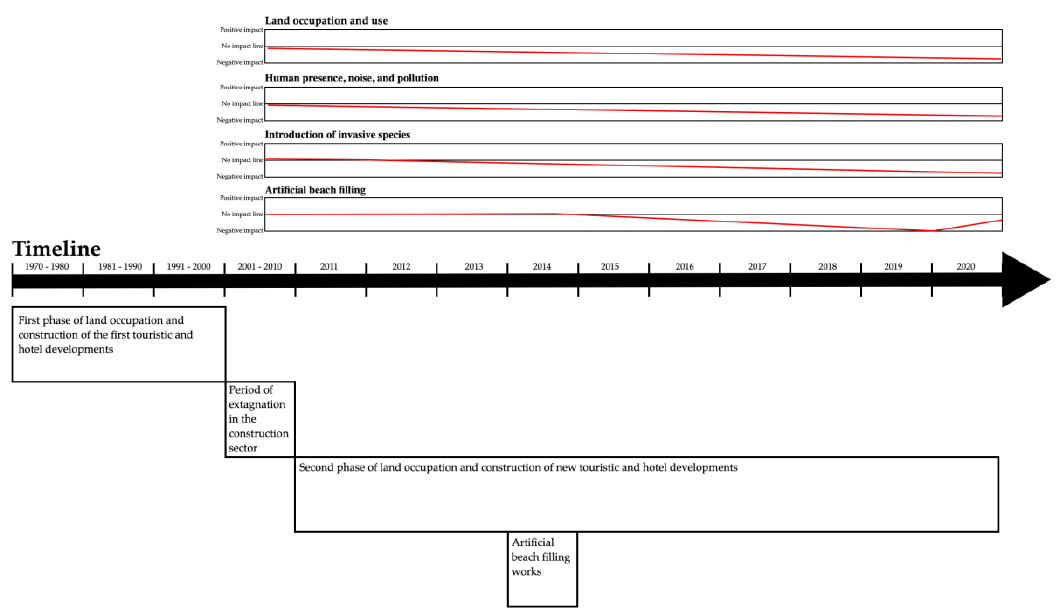
Figure 2. Definition of the main environmental impacts observed and the trend of the evolution of these impacts over time, with the identification of the main periods of occurrence of the stages of development of civil construction in the area under study.